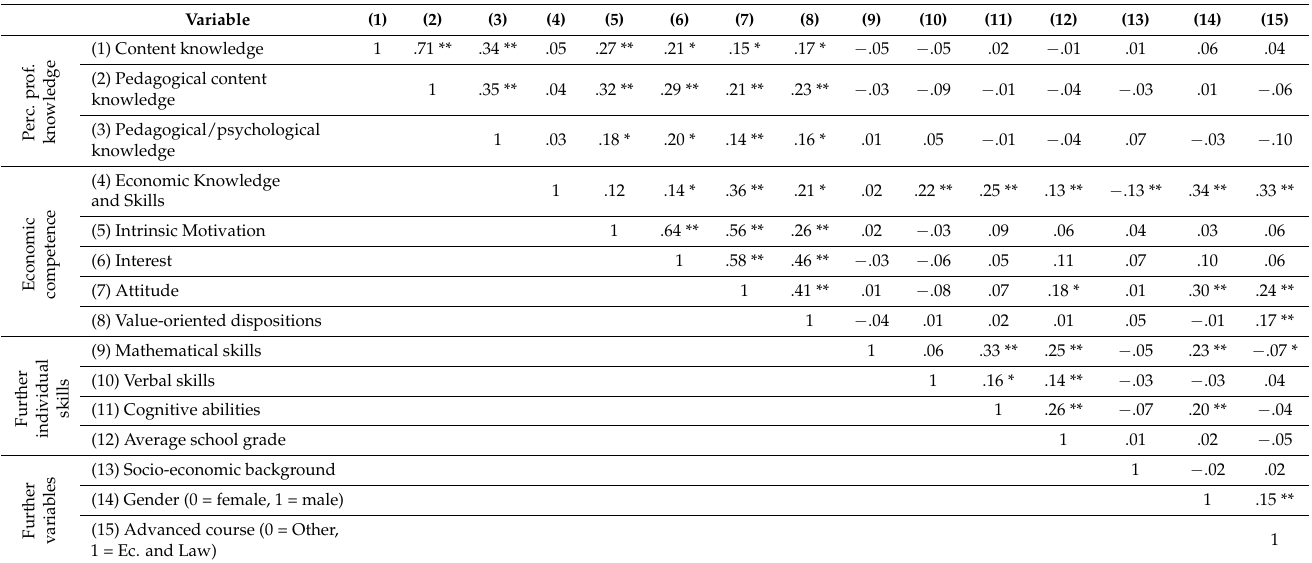
Table 10. Interrelations between independent